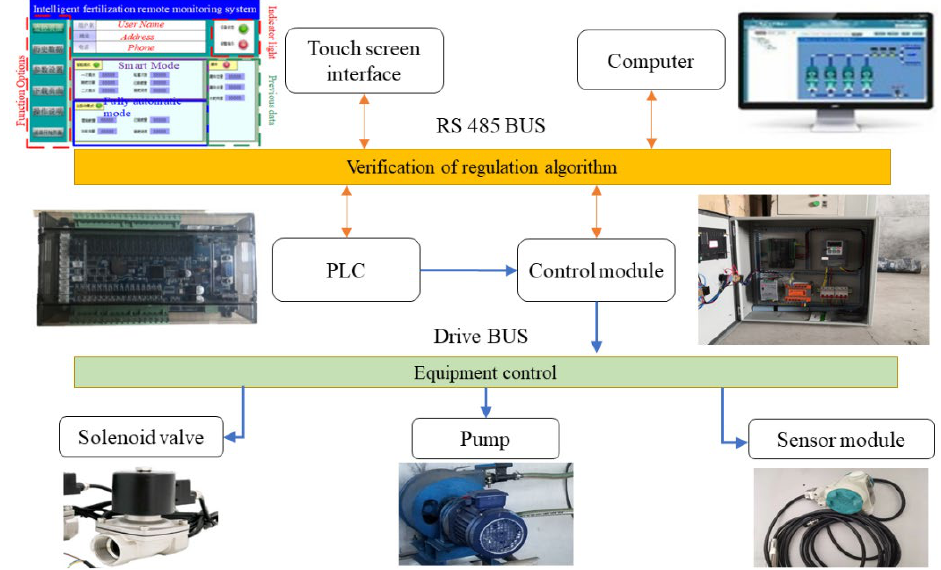
Figure 16. Structure of the fertiliser pH adjustment test system.